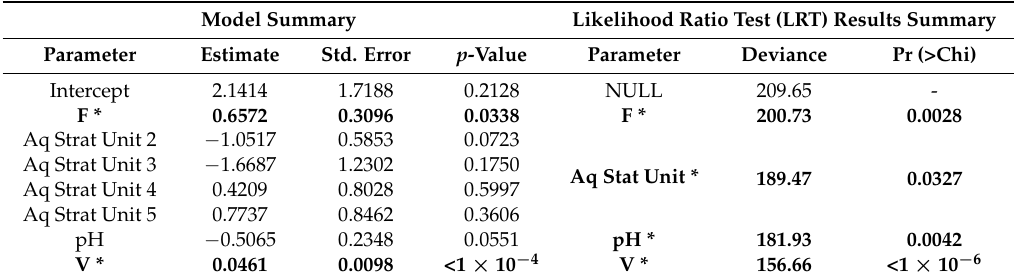
Table 1. Summary of the master logistic regression (LR) model (significant variables at p ≤ 0.05 are shown in bold and